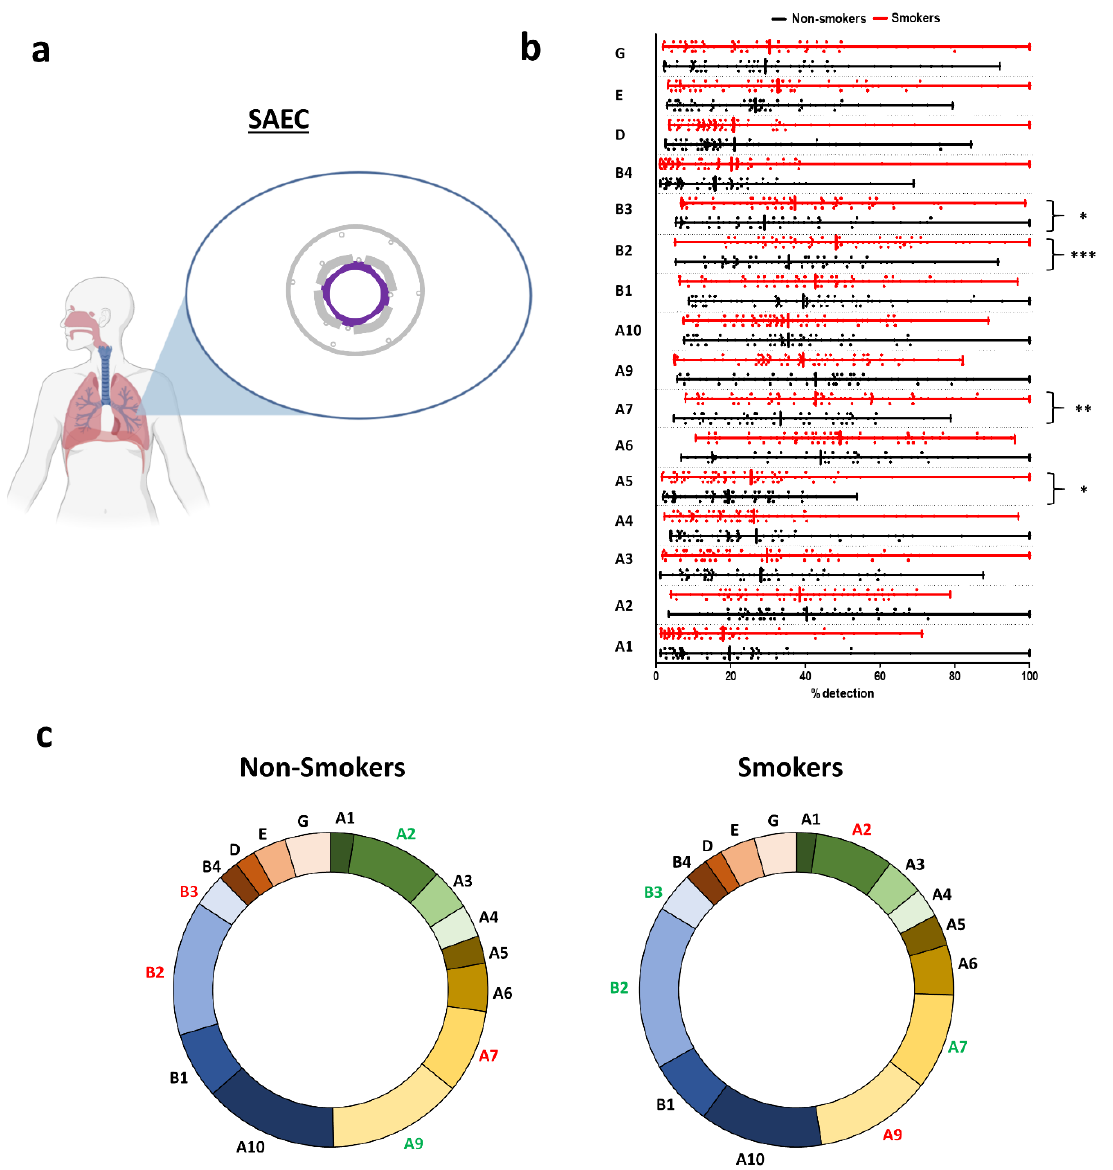
Figure 3. Evaluation of nAChR transcript levels in human small airway epithelial cells (SAECs). ( a ) Illustration depicting the origin of the samples. Isolated AECs were collected from bronchioles. Small airway epithelial cells (SAECs) are depicted in purple. ( b ) Histograms showing the detection of nAChRs in non-smokers (black) and smokers (red). * p < 0.05; ** p < 0.01; *** p < 0.001 non-smokers ( n = 63) vs. smokers ( n = 72). ( c ) Pie charts showing the repartition of nAChRs in non-smokers (left) and smokers (right). Coloured subunits indicate upregulation (green) and downregulation (red) in both groups when statistically significant.